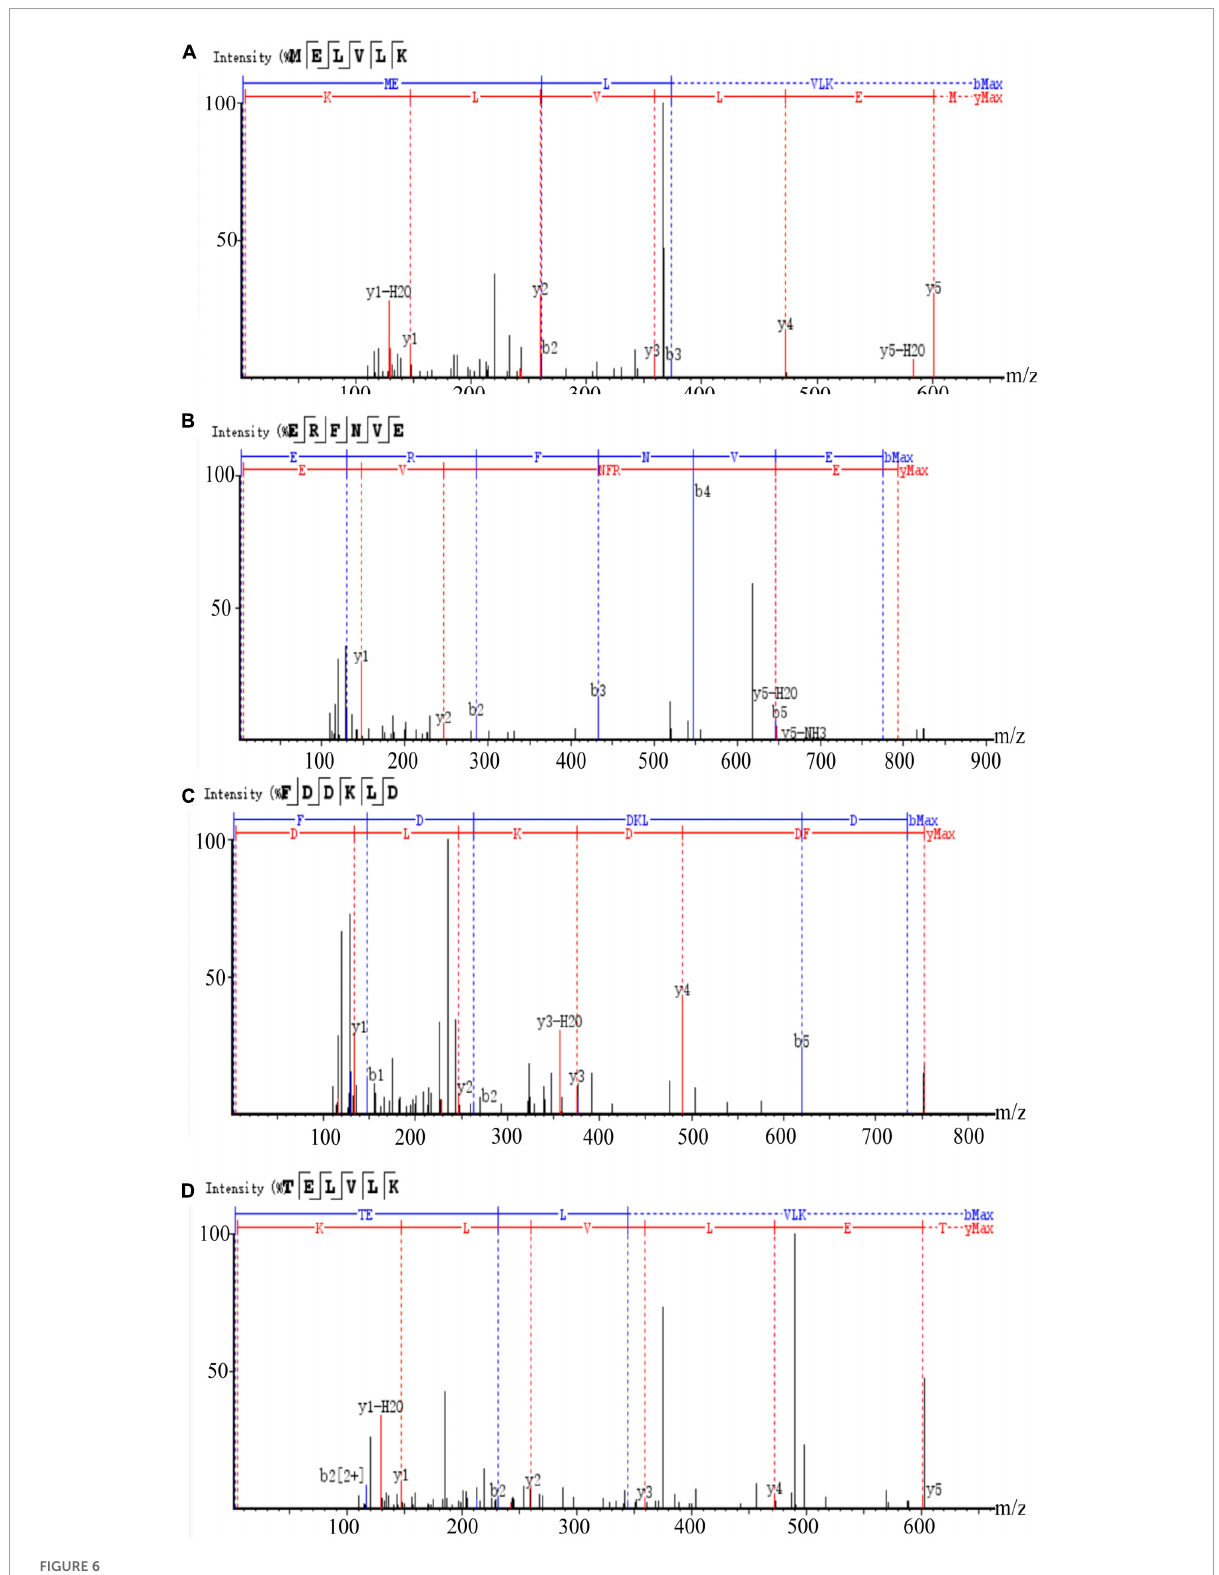
FIGURE6 LC-MS chromatogram of FHMP-V-3: (A) MELVLK; MS/MS spectrum at m/z 366.72, (B) ERFNVE; MS/MS spectrum at m/z 397.19, (C) FDDKLD; MS/MS spectrum at m/z 376.67, and (D) TELVLK; MS/MS spectrum at m/z351.72. All MS/MS spectra were performed under positive mode.